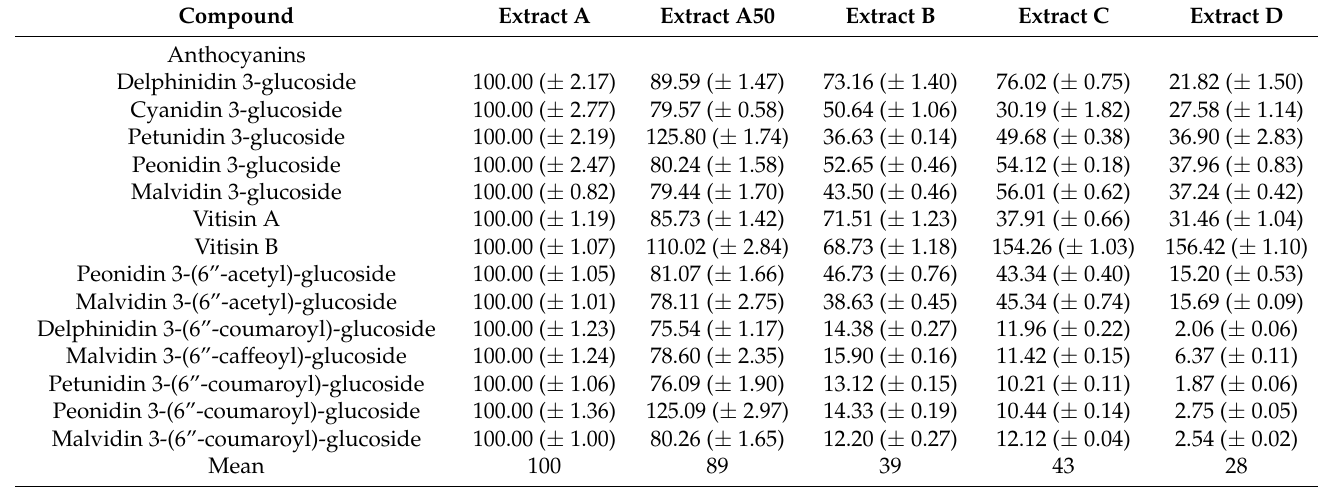
Table 17. Relative percentage (mean ± SD) of each anthocyanin in extracts A50, B, C and D calculated in respect to the content determined in extract A and set as 100%. The relative percentages were calculated by measuring the areas of the peaks reconstituted by setting the [M-H] − as filter ions. Compound Extract A